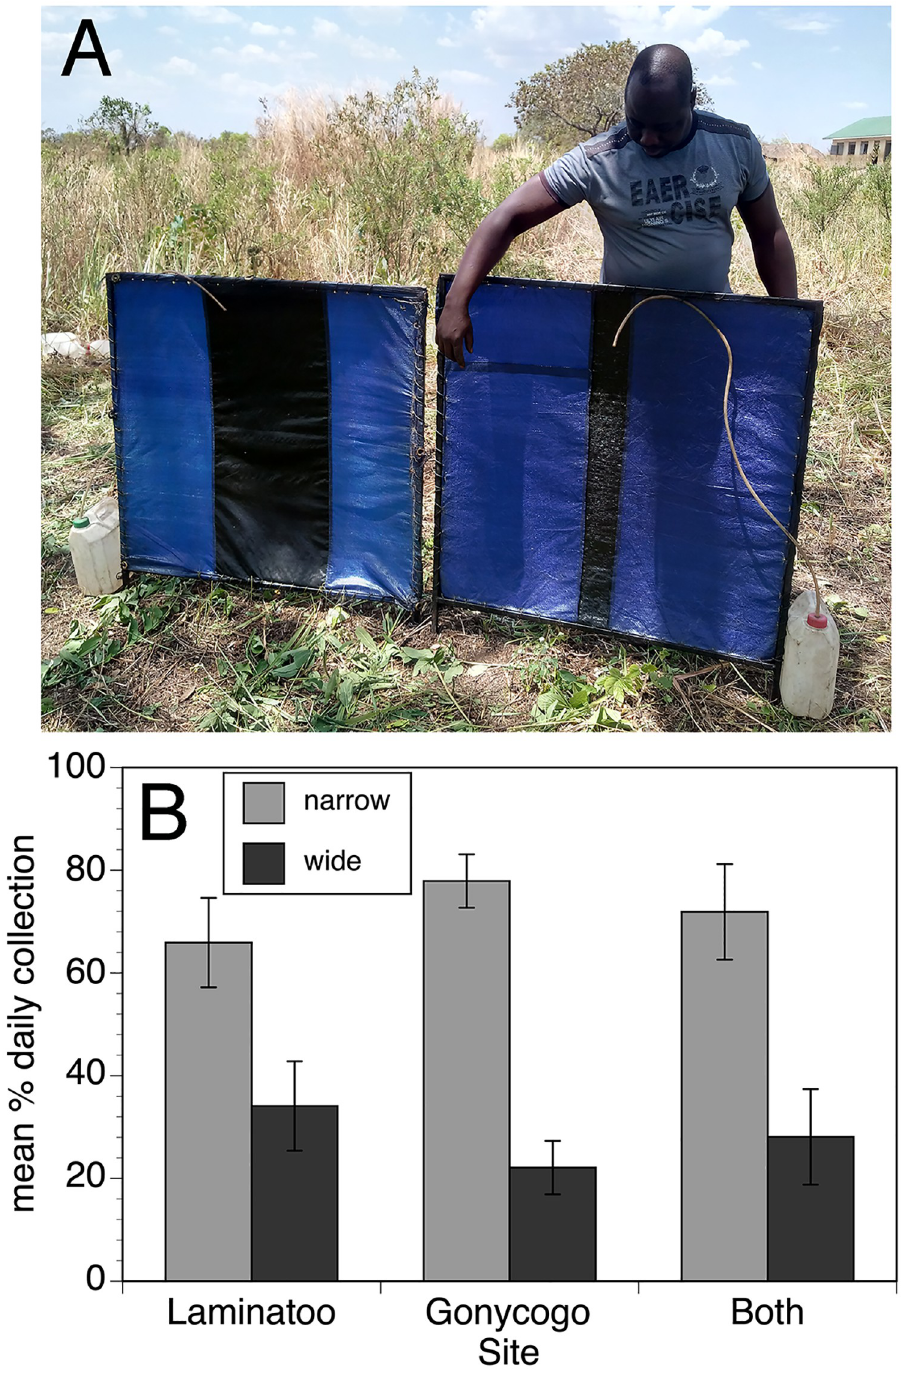
Fig 4. Relative performance of 1m traps with wide and narrow black stripes. Panel A: Photograph of the wide and narrow striped designs. Panel B: Relative performance of the wide and narrow striped trap designs in Laminatoo, Gonycogo and data from both communities combined. Data are presented as the mean percentage of the total collection by day, normalizing for variations in the absolute number of flies collected on each day, as described in Materials and Methods. Error bars indicate the standard deviation associated with the means. The analysis was conducted on data collected from 12 paired trials each in Laminatoo and Gonycogo. Raw collection data for this study may be found in the S3